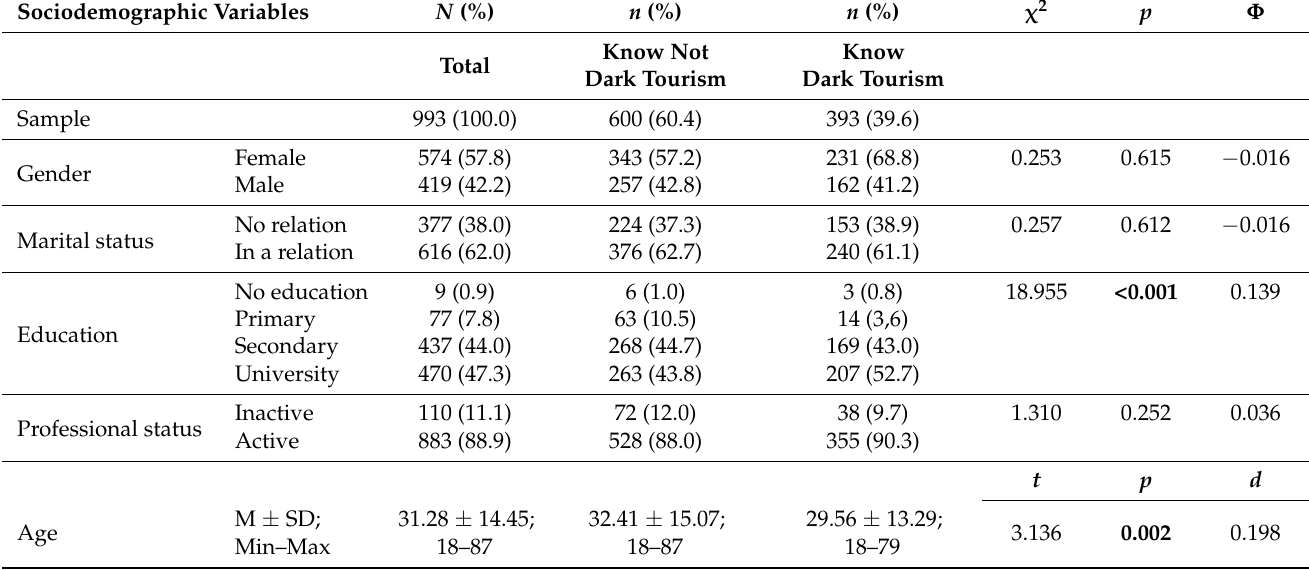
Table 1. Sample sociodemographic characteristics.